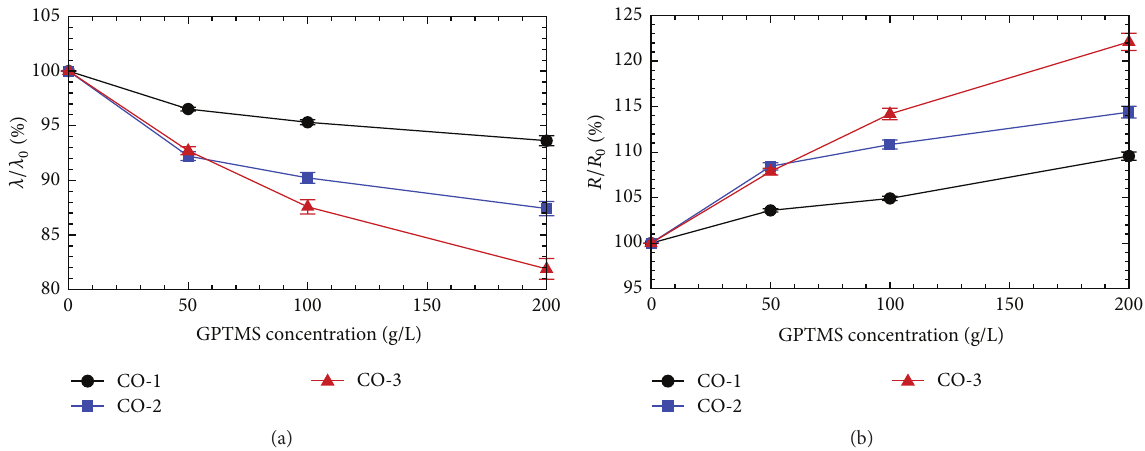
Figure 8: GPTMS concentrations influence on plain CO fabrics thermal properties: thermal conductivity (a) and resistance (b).